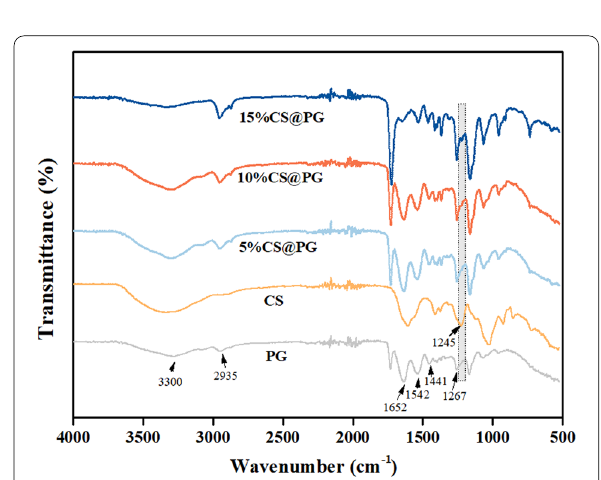
Fig. 4 FT-IR spectrum of the CS@PG electrospun